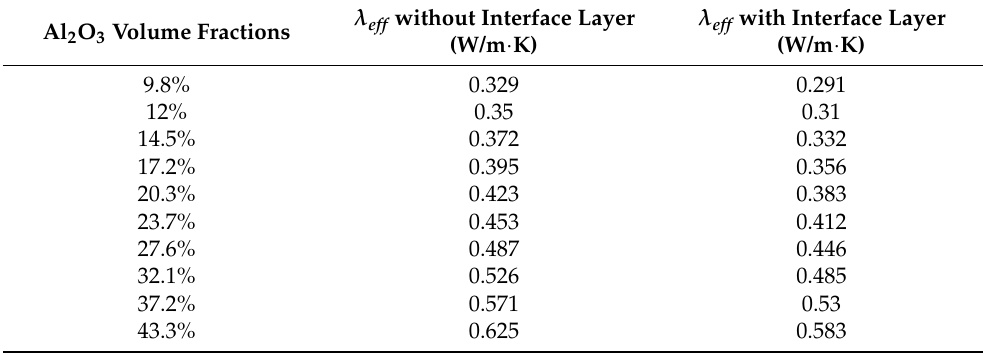
Table 1. The thermal conductivity of LLDPE/Al 2 O 3 composites with different volume fractions via ANSYS